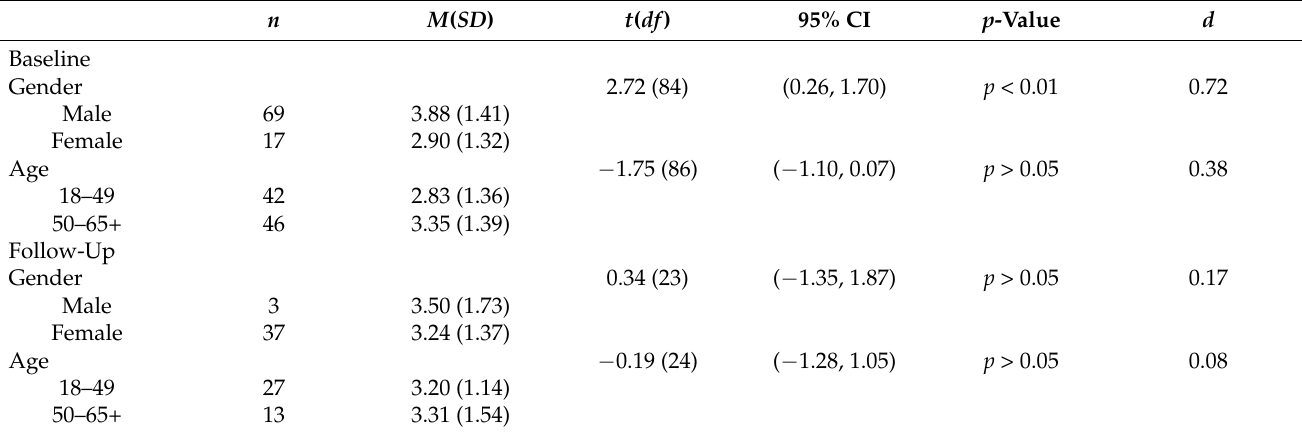
Table 4. Differences by demographic groups in baseline and follow-up COVID-19 vaccine